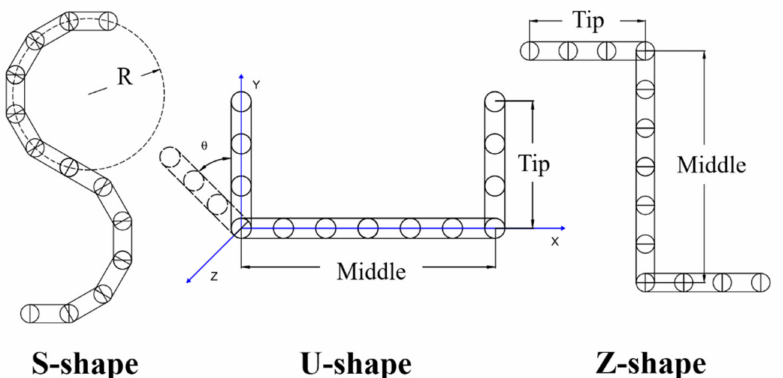
Figure 5. Sketches of S-shaped, U-shaped, and Z-shaped fibers. For the U-shaped and Z-shaped fibers, the length of the middle part is twice the length of each tip.